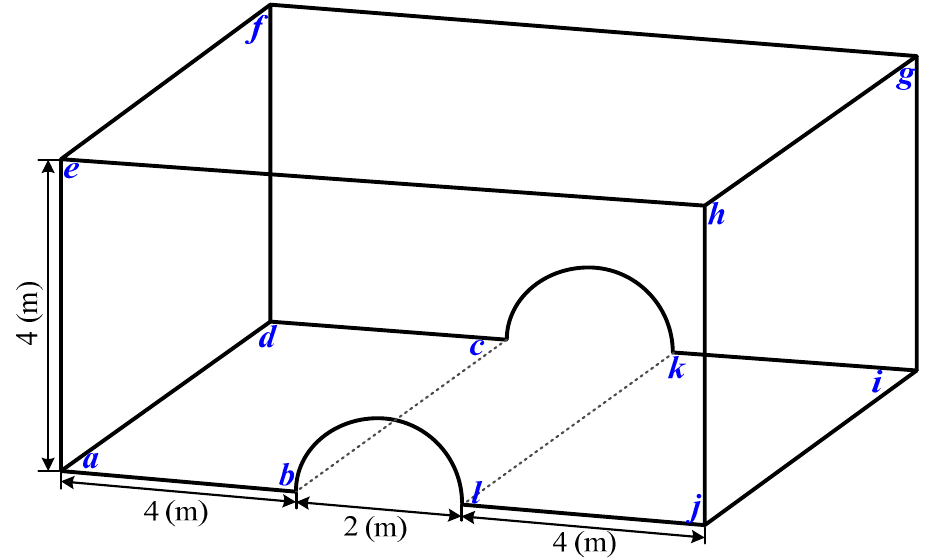
Figure 8. Laminar flow around a cylinder in three dimensions.